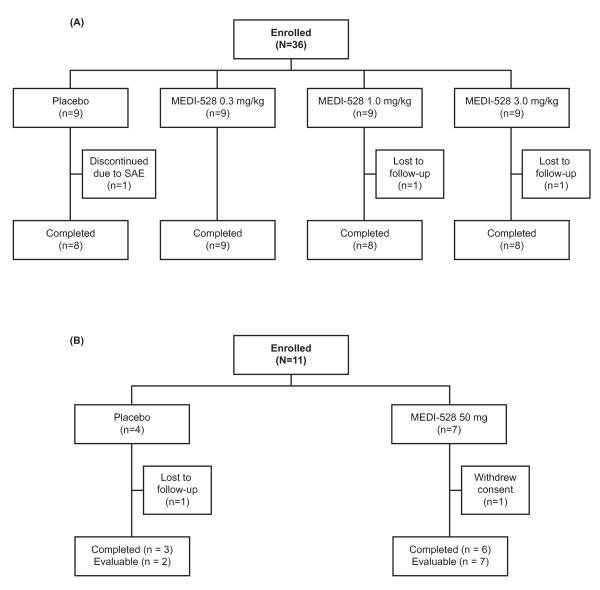
Flow diagram for subjects in studies 1 (A) and 2 (B).